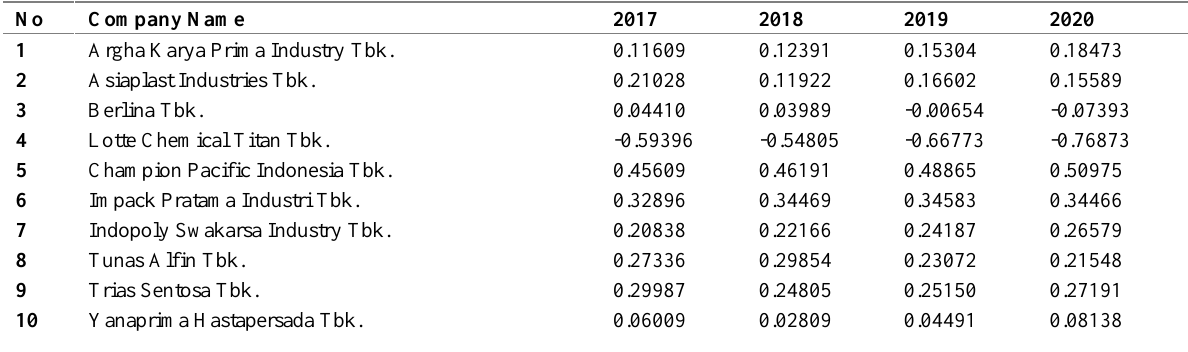
Table 2: Retained Earnings to Total Assets of Sample